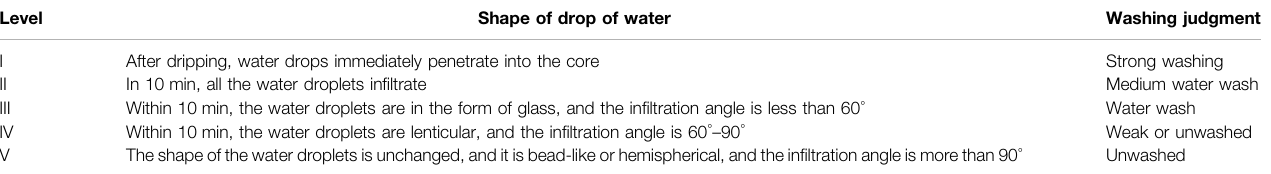
TABLE 2 | Classi fi cation table of dripping